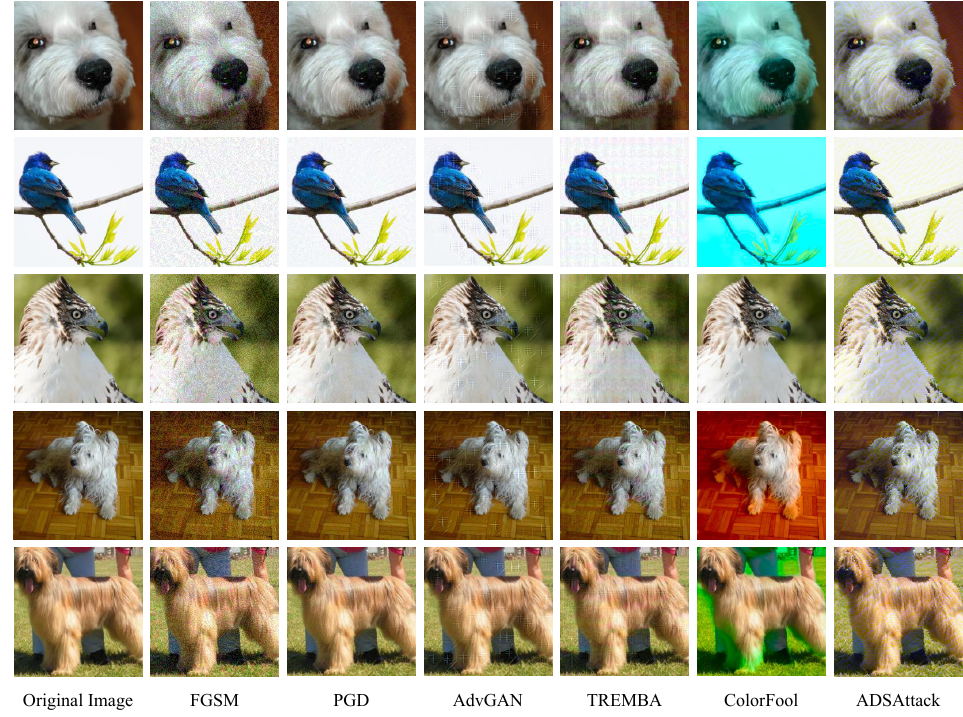
Figure 6. Visual comparison results. The exhibited images are clean images and their adversarial versions generated by the compared algorithms—FGSM, PGD, AdvGAN, TREMBA, ColorFool and our ADSAttack.